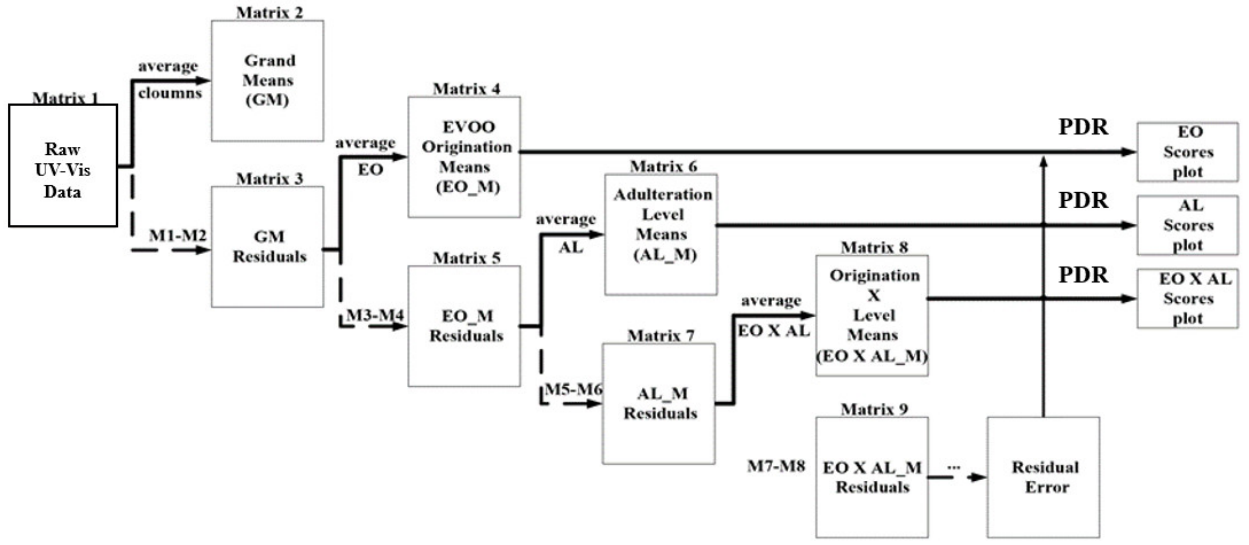
Figure 1. Schematic diagram for analysis of variance-projected difference resolution (ANOVA- PDR). The matrix decomposition process was repeated for the other experimental factors and the factor interactions.